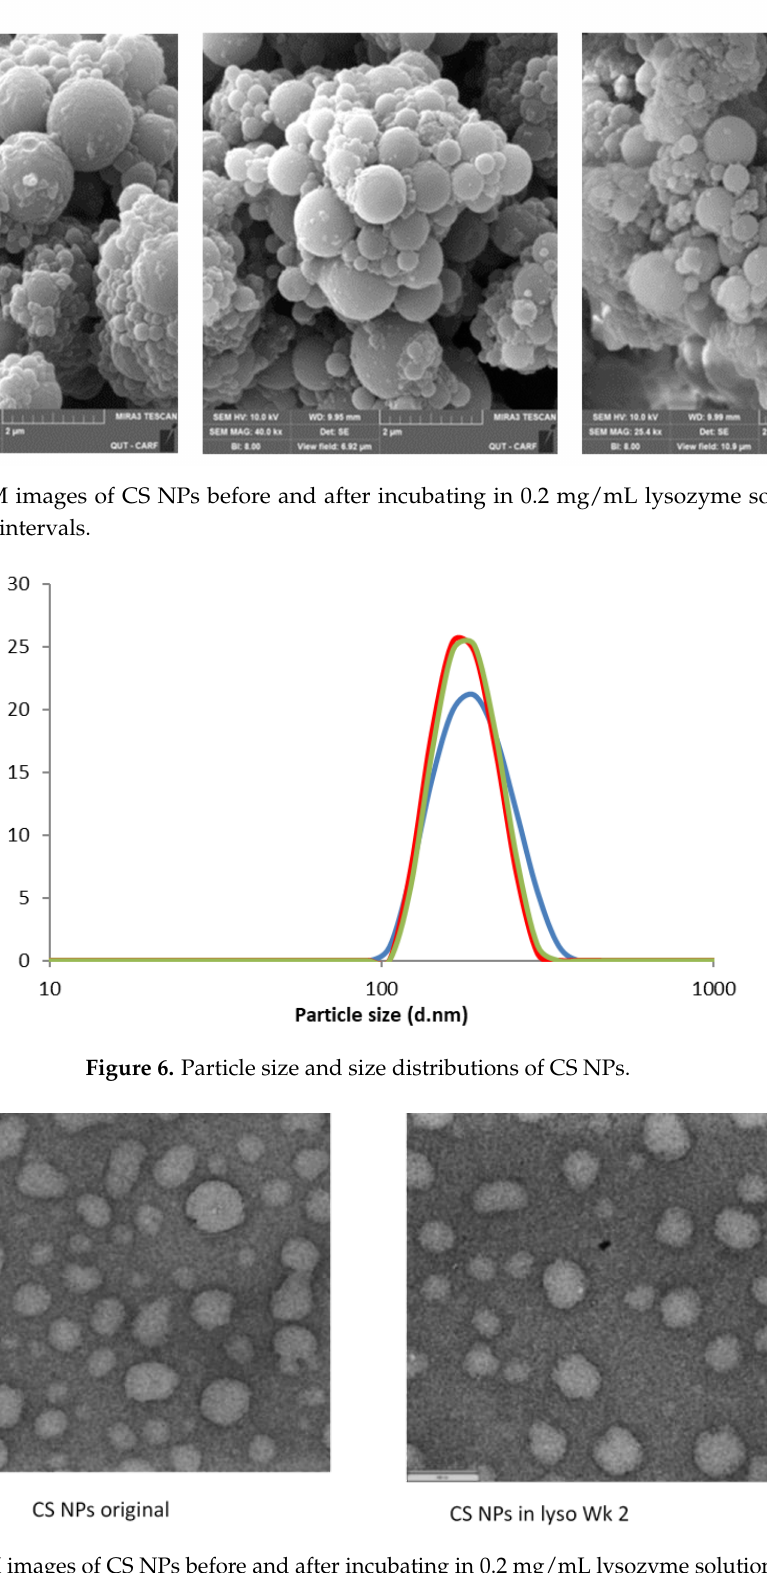
Figure 7. TEM images of CS NPs before and after incubating in 0.2 mg/mL lysozyme solution at 37 °C (TEM images for samples incubated up to 10 weeks could not be performed).